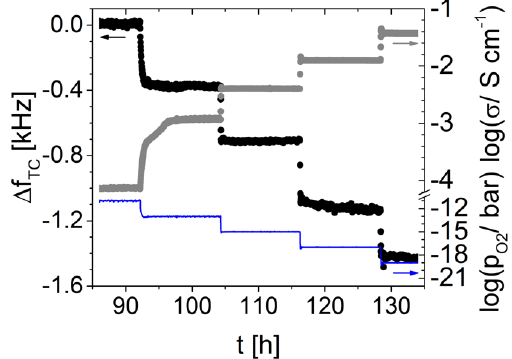
Figure 14. Temperature-compensated resonance frequency of a 5MHz resonator coated with a TiO 2- δ oxide electrode, electrical conductivity of a TiO 2- δ thin film, and adjusted oxygen partial pres- sure over time at 700 ◦ C.